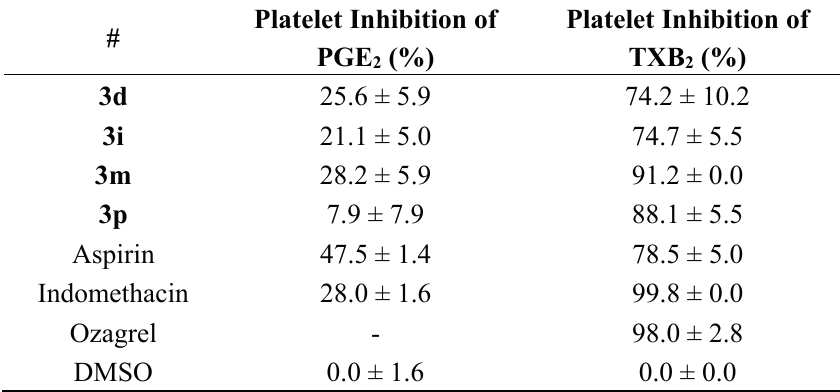
Table 2. Effects of novel antiplatelet N,N' -disubstituted thiourea derivatives (100 µM) on PGE 2 and TXB 2 production determined by Enzyme Immunoassay (EIA) in comparison to dimethylsulfoxide (DMSO, 1%), Ozagrel (100 µM), Aspirin (100 µM) and Indomethacin (100